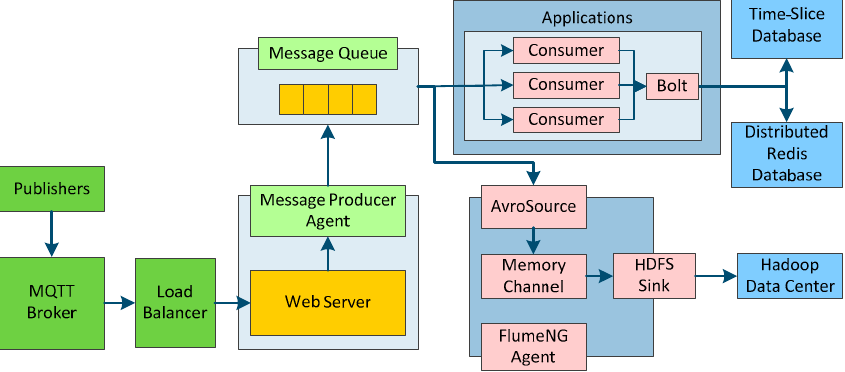
Figure 16. The software architecture of a cloud node, utilized by EMULSION.